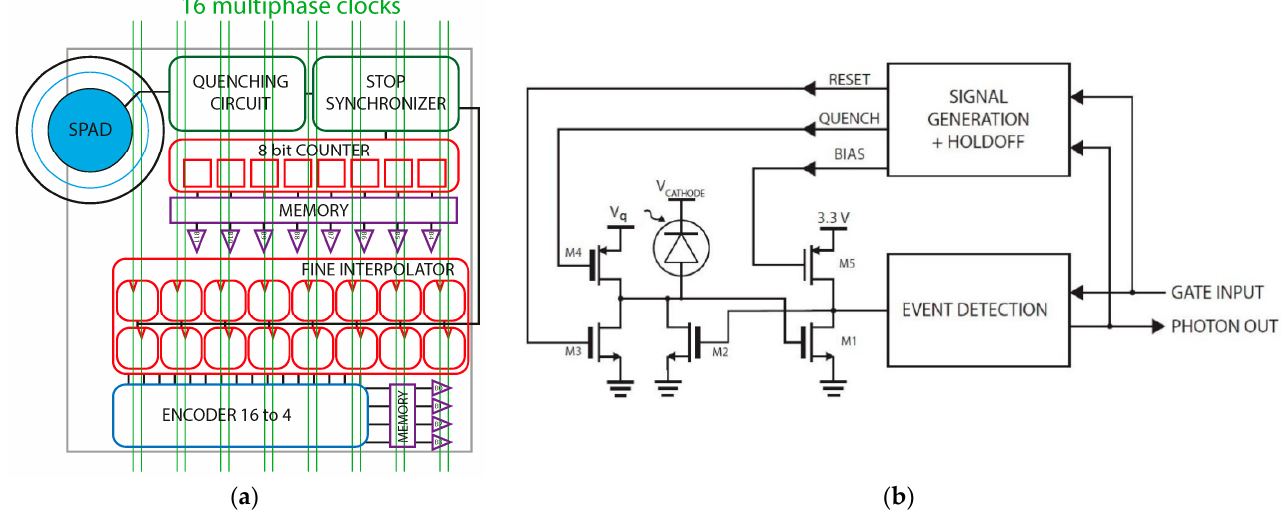
Figure 14. ( a ) Smart-pixel block diagram and ( b ) SPAD front-end circuitry for active gating